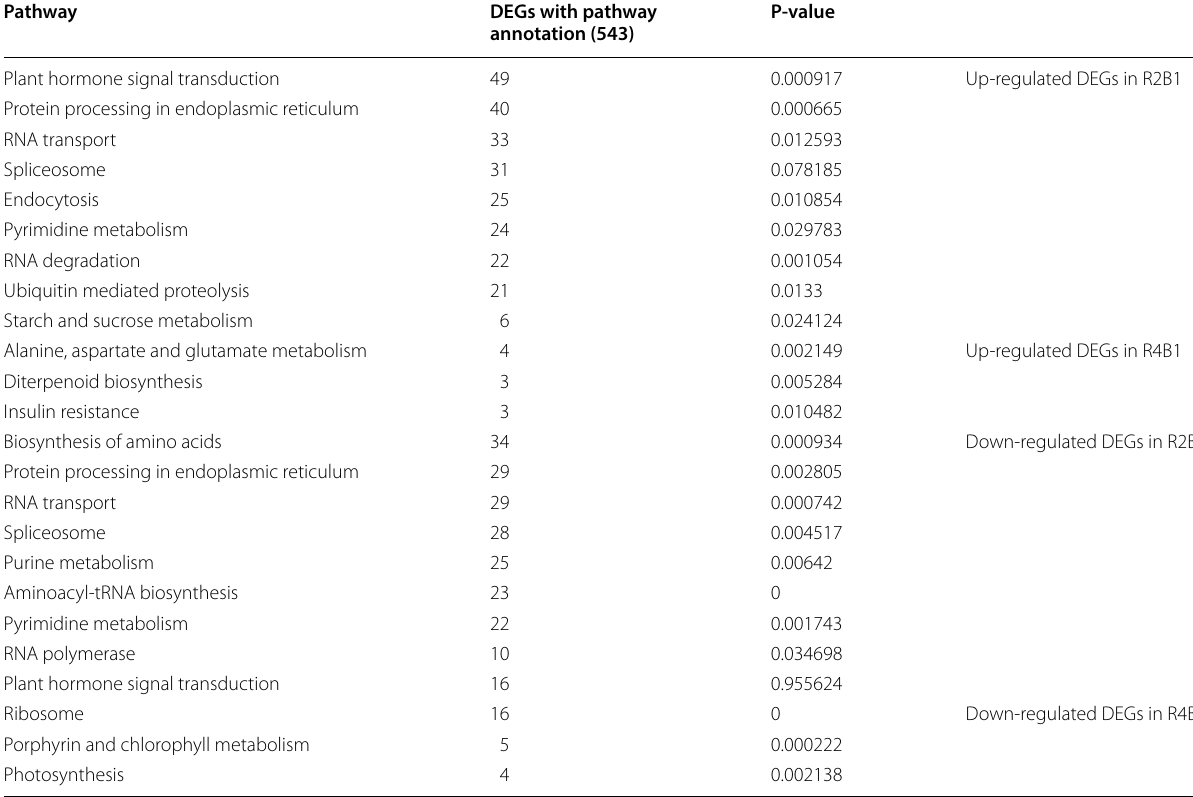
Table 3 Kyoto encyclopedia of genes and genomes (KEGG) pathway enrichment of significantly up/down-regulated DEGs in R2B1/R4B1 Pathway DEGs with pathway annotation